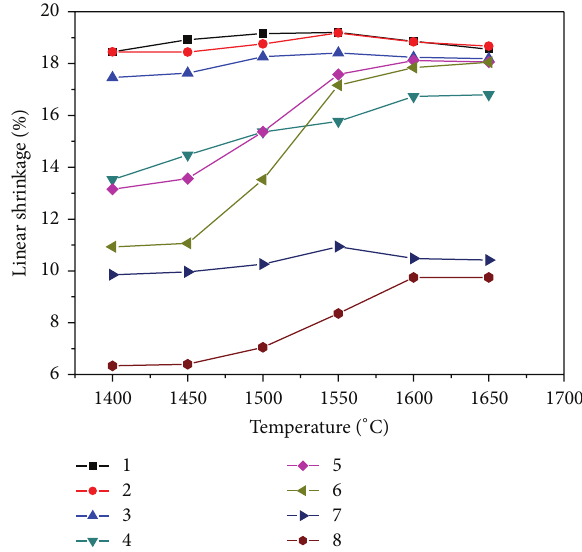
Figure 2: XRD patterns of the uncoated and coated 3Y-TZP powders. Figure 3: Linear shrinkage of the samples at different temperatures (1: 30–50 nm, uncoated; 2: 50–100 nm, uncoated; 3: 100–300 nm, uncoated; 4: 300–500 nm, uncoated; 5: 30–50 nm, coated; 6: 50– 100 nm, coated; 7: 100–300 nm, coated; 8: 300–500 nm, coated).